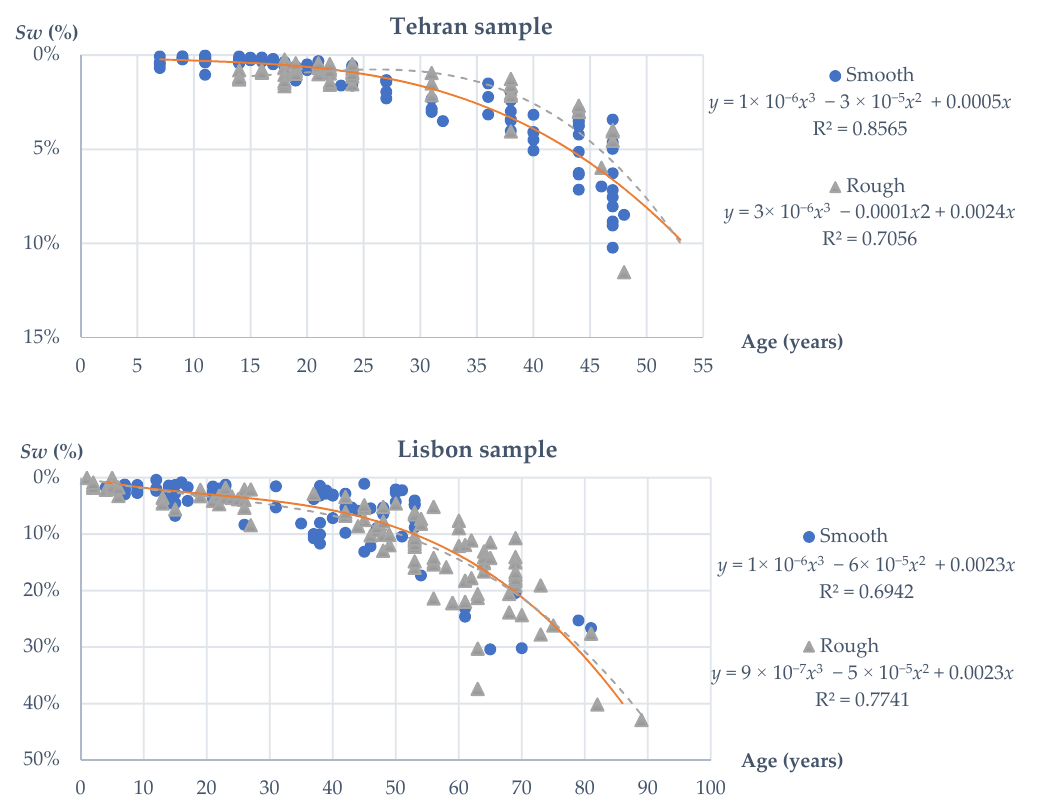
Figure 11. Degradation curves of the Tehran and Lisbon samples, according to the type of finishing. Regarding the evolution of the degradation condition of stone claddings according to the size of the stone elements (Figure 12), the results reveal that claddings with medium size plates (area < 0.4 m 2 ) present longer estimated service lives than those with larger stone plates (area ≥ 0.4 m 2 ). As mentioned by Silva et al. [2], this can probably be explained by the fact that the larger the size of the stone elements, the greater the cladding’s susceptibility to weather effects, in addition to the lower relative area of the joints in the larger plates and a resulting higher concentration of stresses, which can promote a higher incidence of defects. Based on the degradation curves (Figure 11), an estimated service life of 67 and 61 years was obtained for the Tehran claddings with medium and large stone plates, respectively, and 71 and 66 years for the Lisbon sample.